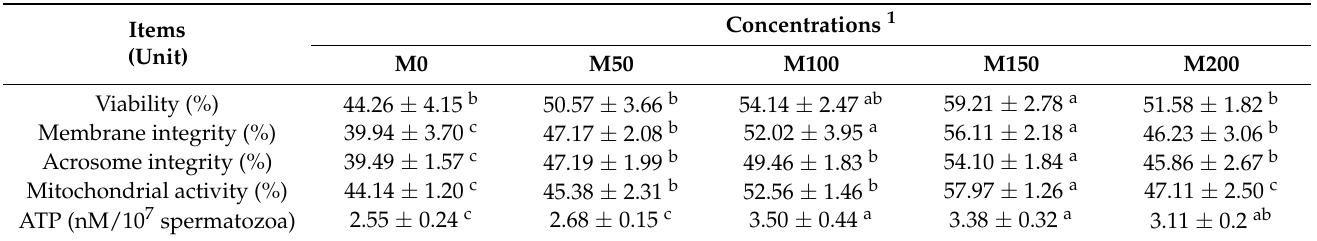
Table 2. Influence of different concentrations of mitoquinone (MitoQ) on the post-thawed sperm quality parameters of rooster semen.